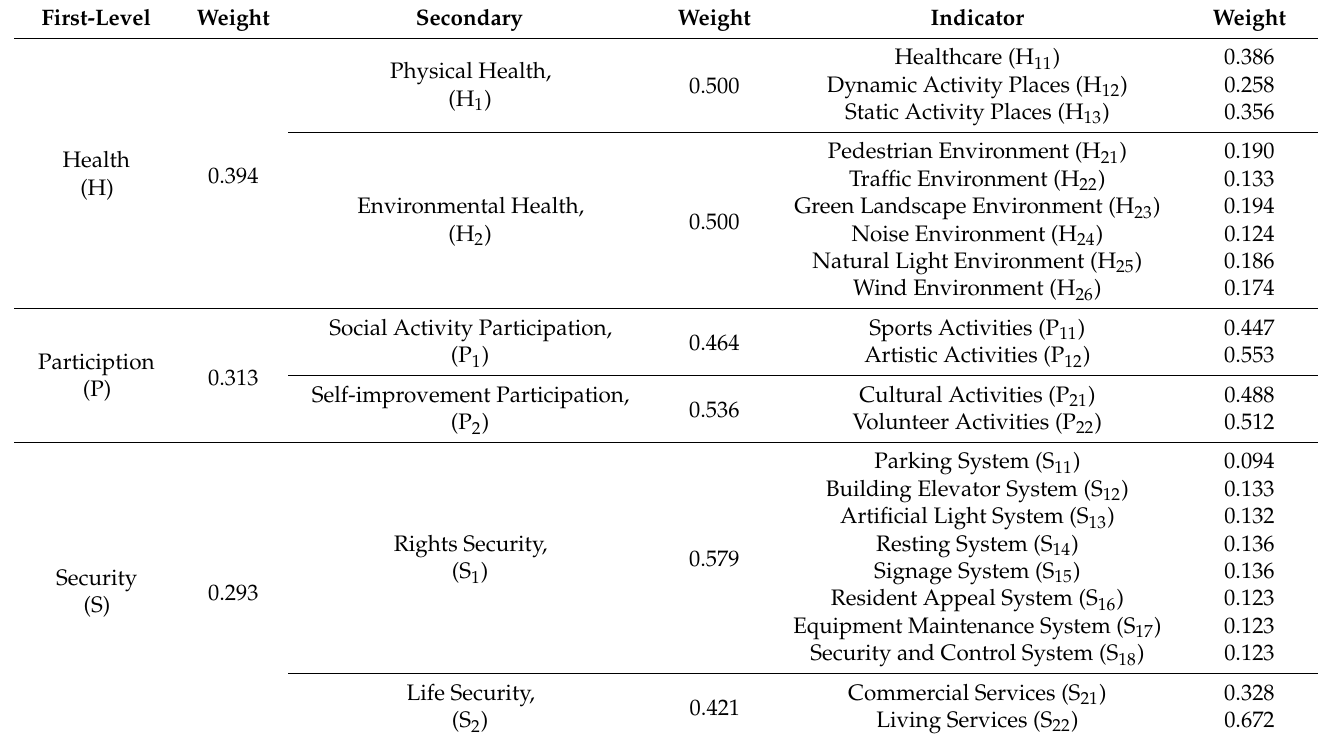
Table 2. Weight of